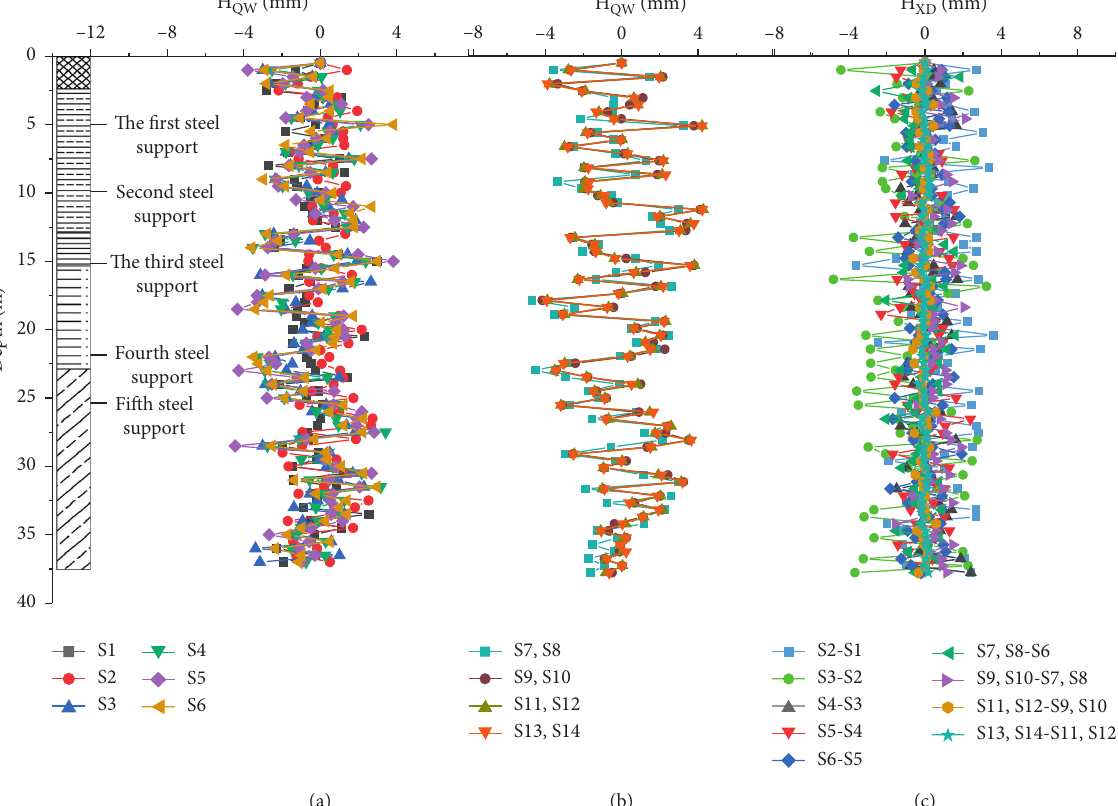
Figure 14: Horizontal deformation of ground connecting